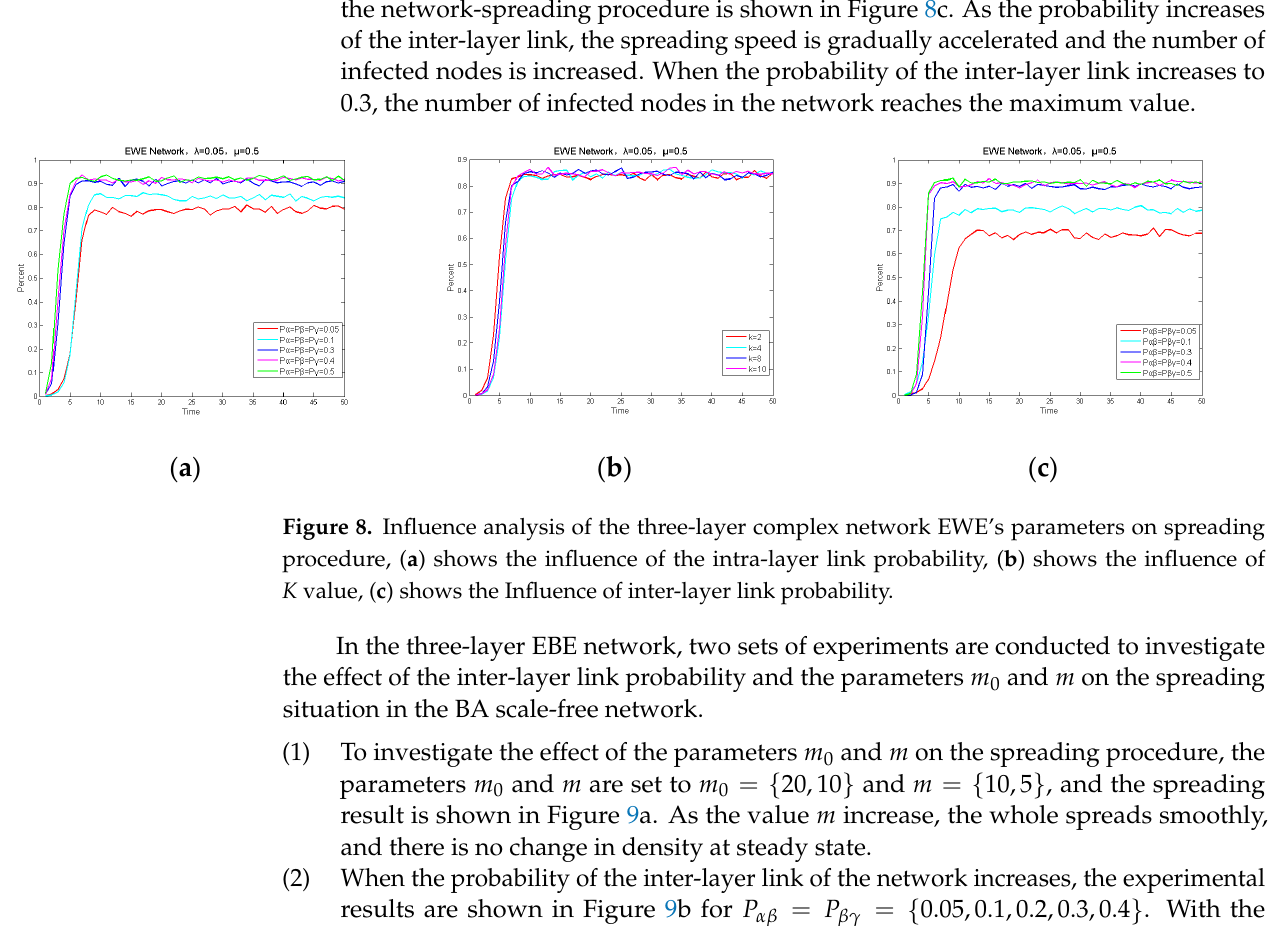
Figure 7. Influence analysis of the three-layer complex network EEE’s parameters on spreading pro- cedure, ( a ) shows the influence of the intra-layer link probability, ( b ) shows the influence of the inter-layer link probability